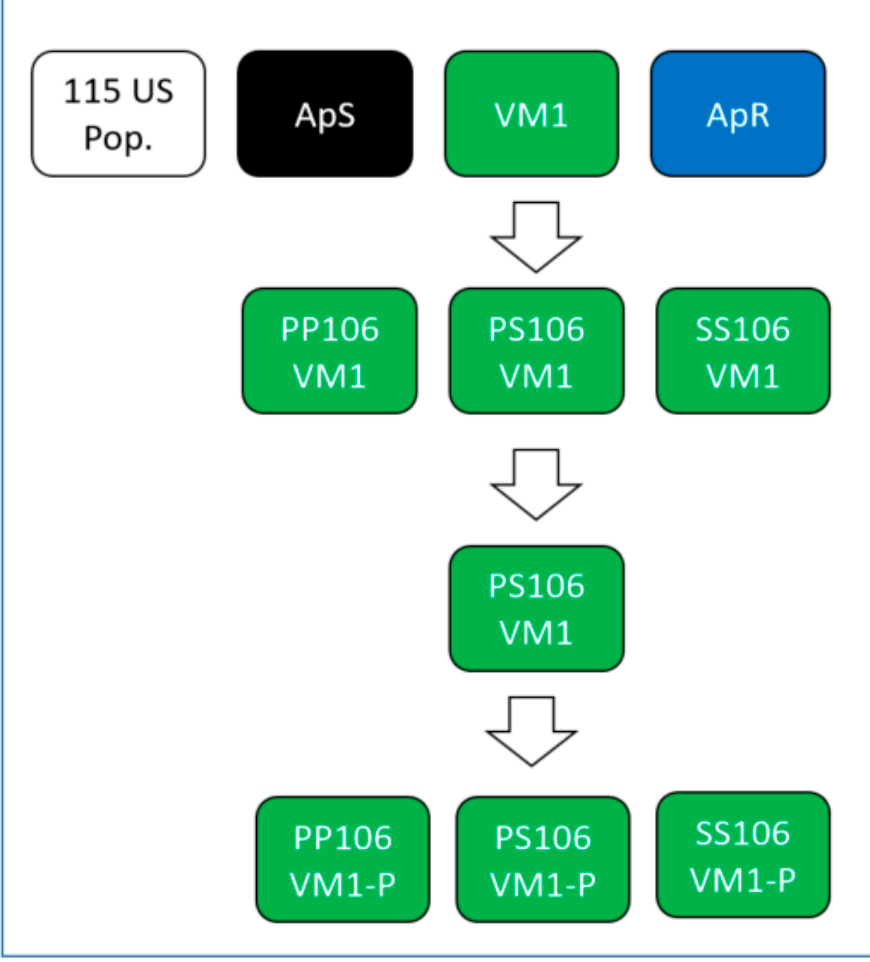
Figure 5. Amaranthus palmeri populations employed in this study.